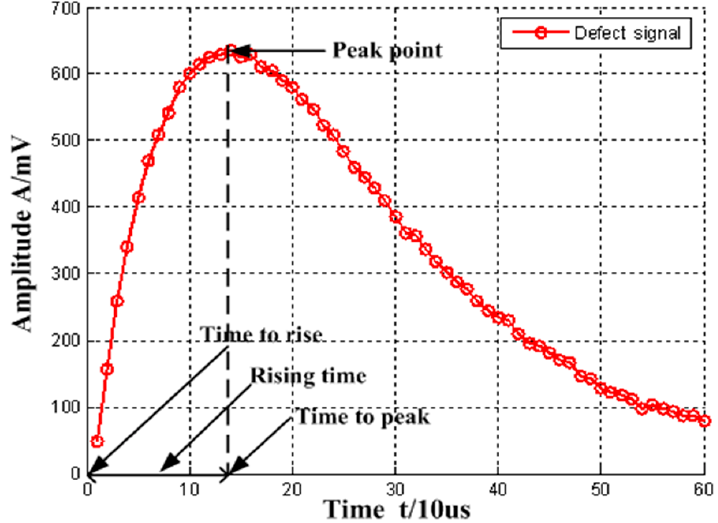
Figure 3. A-scan response and its features.